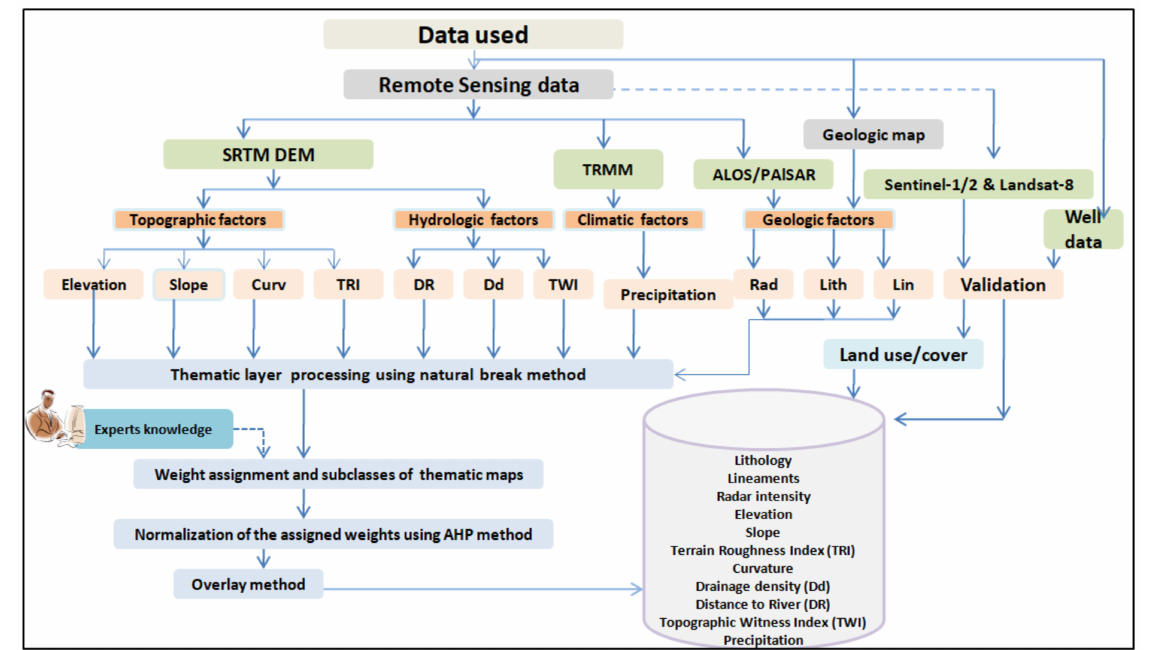
Figure 3. Data used and methods performed in the present